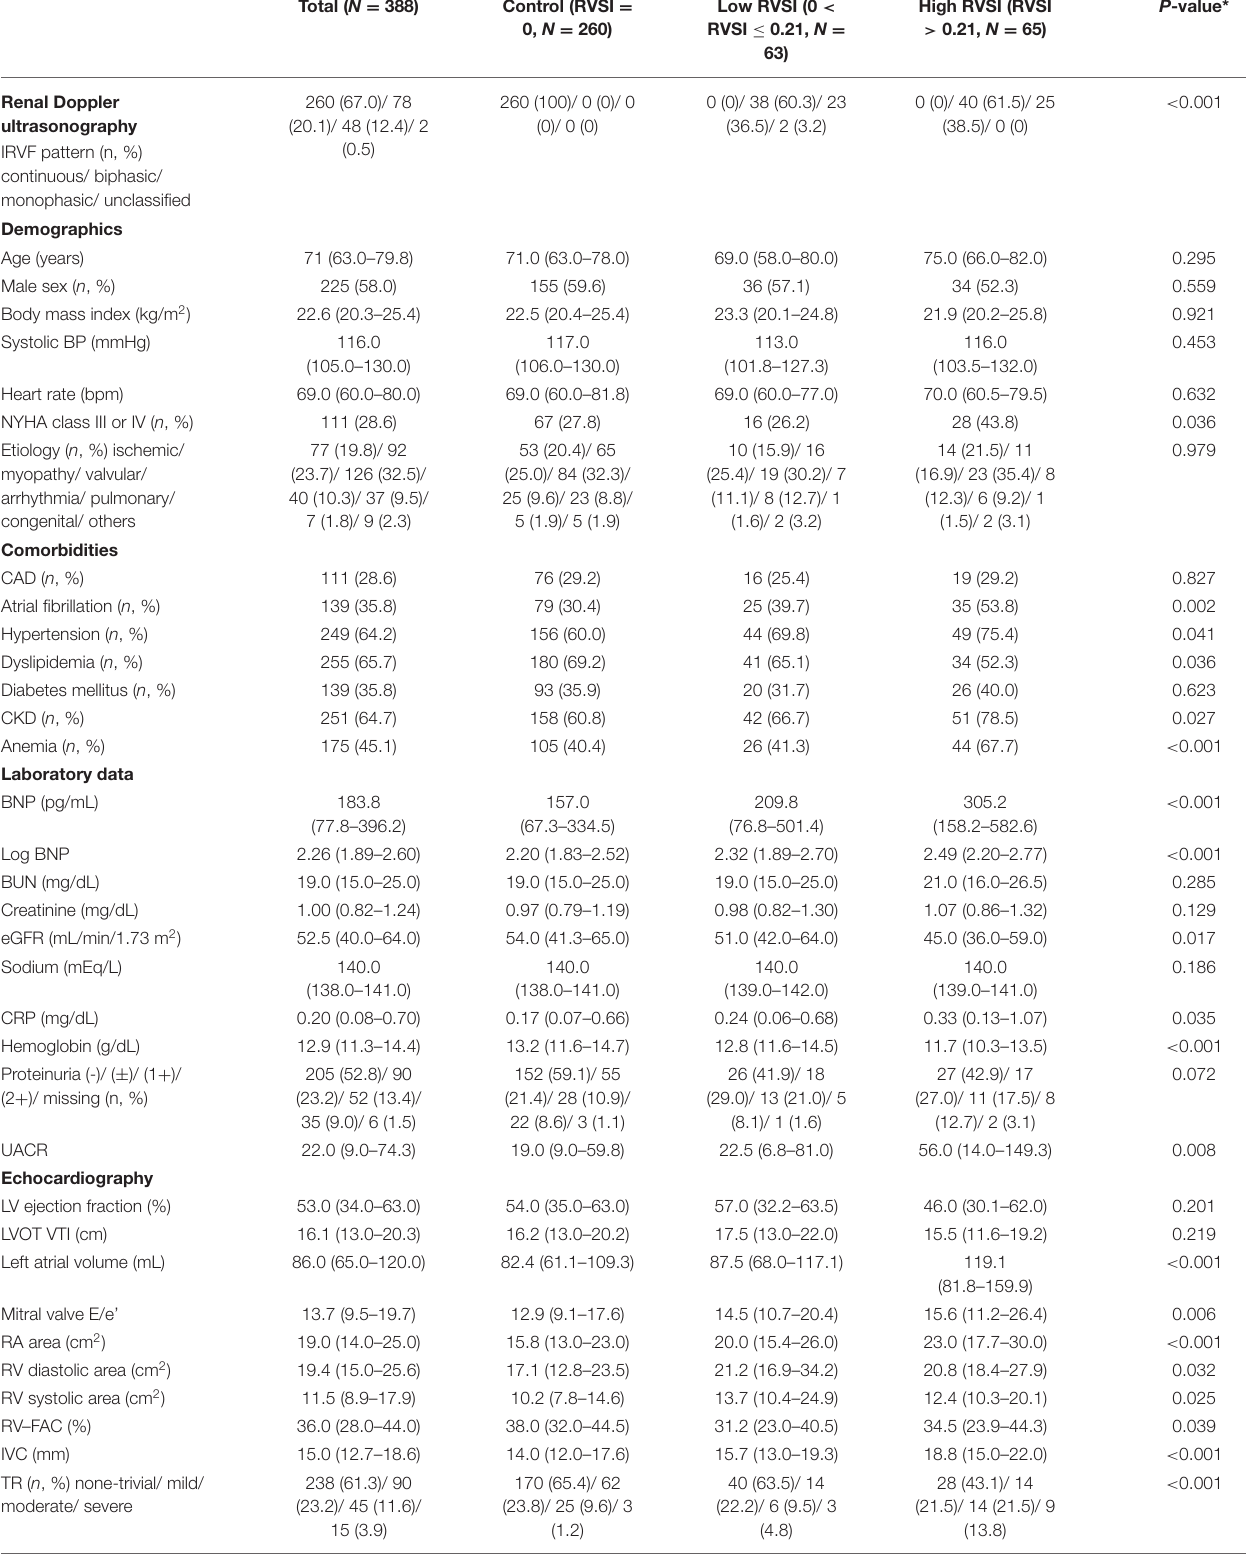
Total ( N = 388) Control (RVSI =